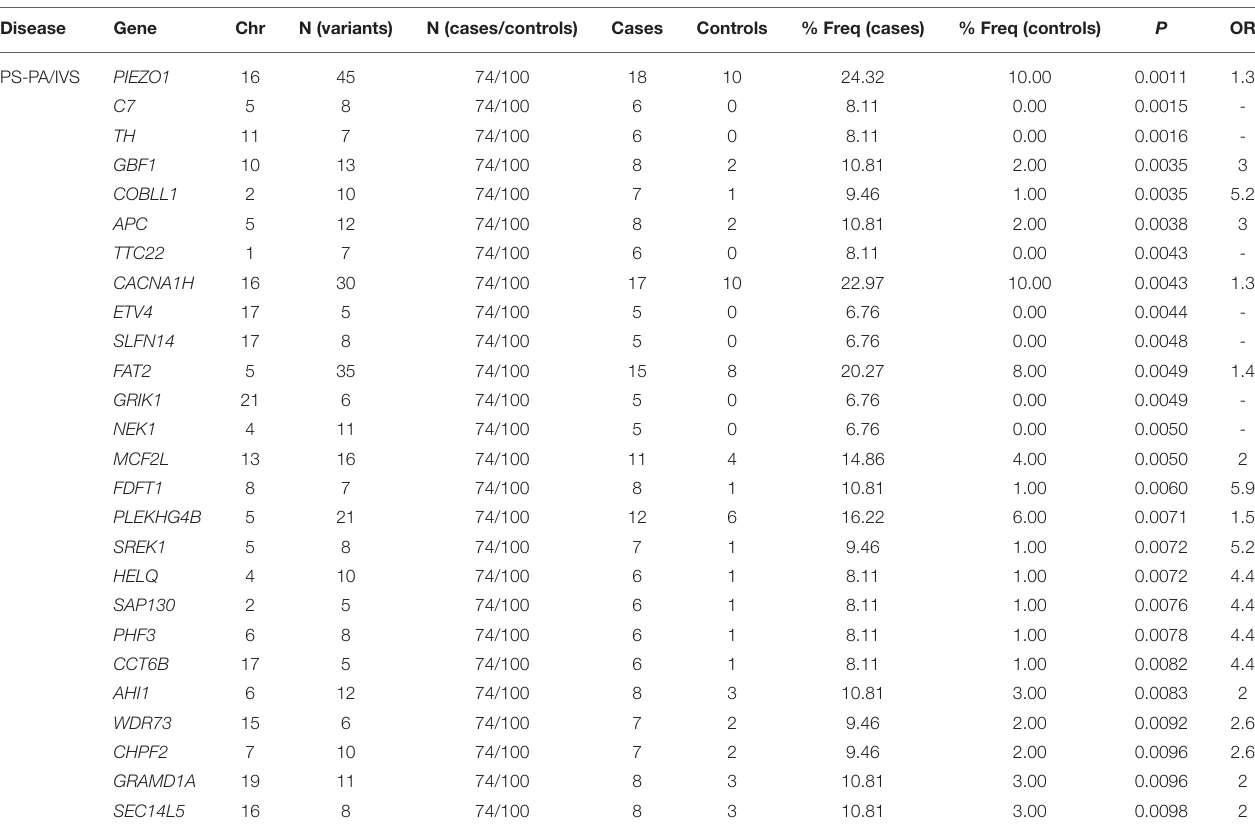
TABLE 1 | A list of genes with the potential pathogenicity of disease were identified by burden test. Disease Gene Chr N